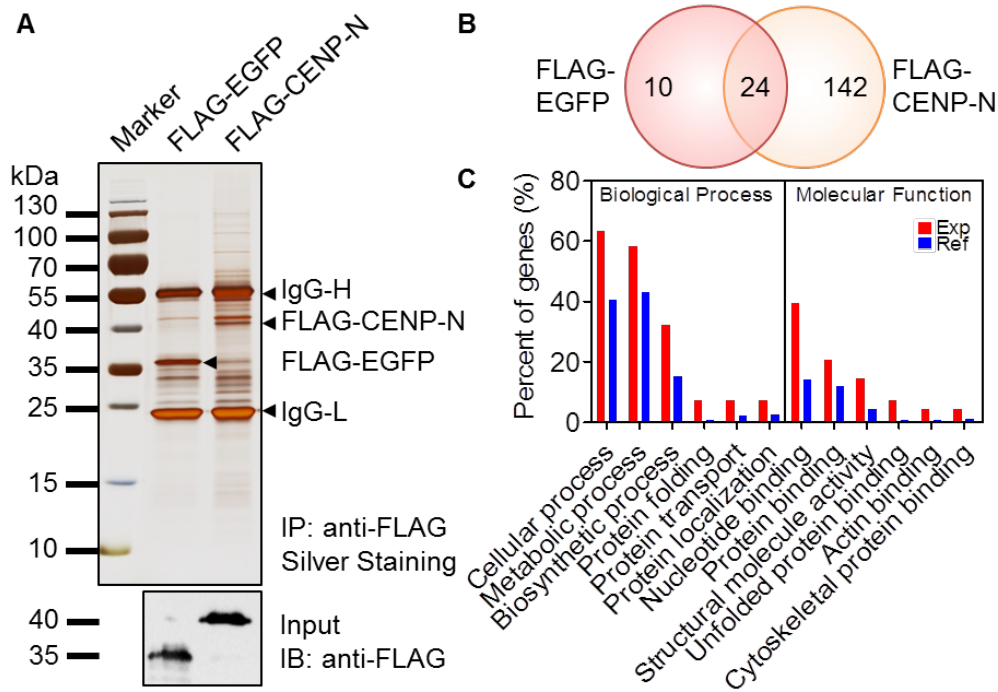
Figure 2. Identification of the CENP-N complex. ( A ) Silver stained SDS-PAGE gel of anti-FLAG a ffi nity purifications from the indicated stable cell lines. Arrowheads indicated the target proteins and heavy / light chains of IgG. Input proteins were also used to detect the target proteins by Western blotting. ( B ) Venn diagram assay of the potential CENP-N interacting proteins identified by LC-MS / MS. ( C ) Functional annotation of the CENP-N interacting proteins as experiment group (Exp) was analyzed by WEGO, and the total silkworm genes as reference group (Ref) were also shown in the figure. Proteins were classified into molecular function and biological process according to their GO signatures.